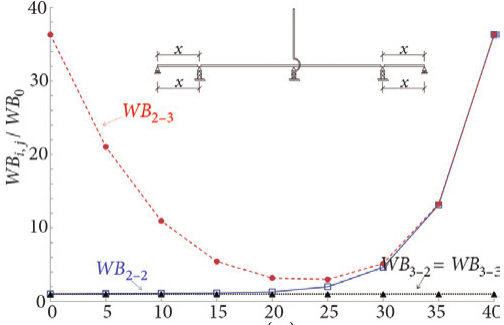
Fig. 4. Ratio between the bending energy of different structures with stays and construction joints and the bending energy of the continuous beam for different locations of the temporary supports and the construction